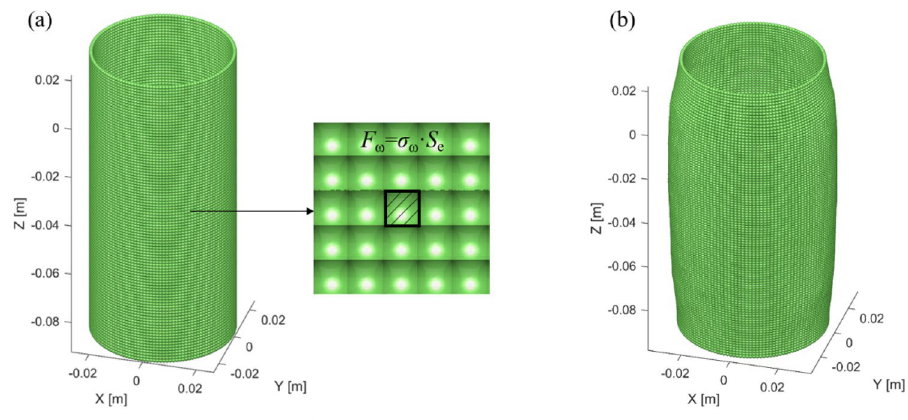
Figure 4. The flexible membrane used in this paper: ( a ) un-deformed membrane with regular packing; ( b ) deformed membrane at 18% axial strain.